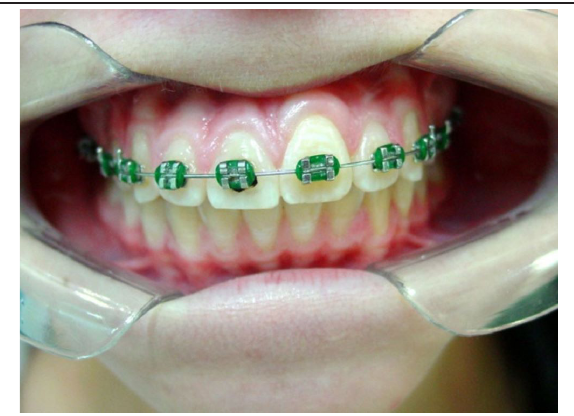
FIGURA 11 – Instalação do aparelho ortodôntico